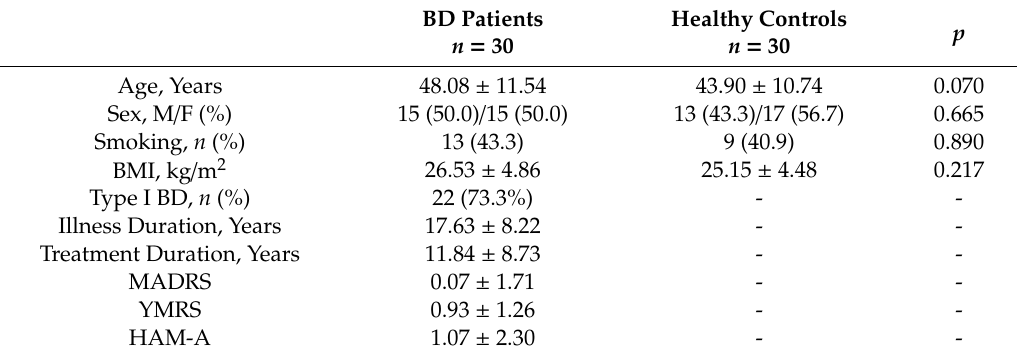
Table 1. Clinical and demographic characteristics of the patient and control groups.